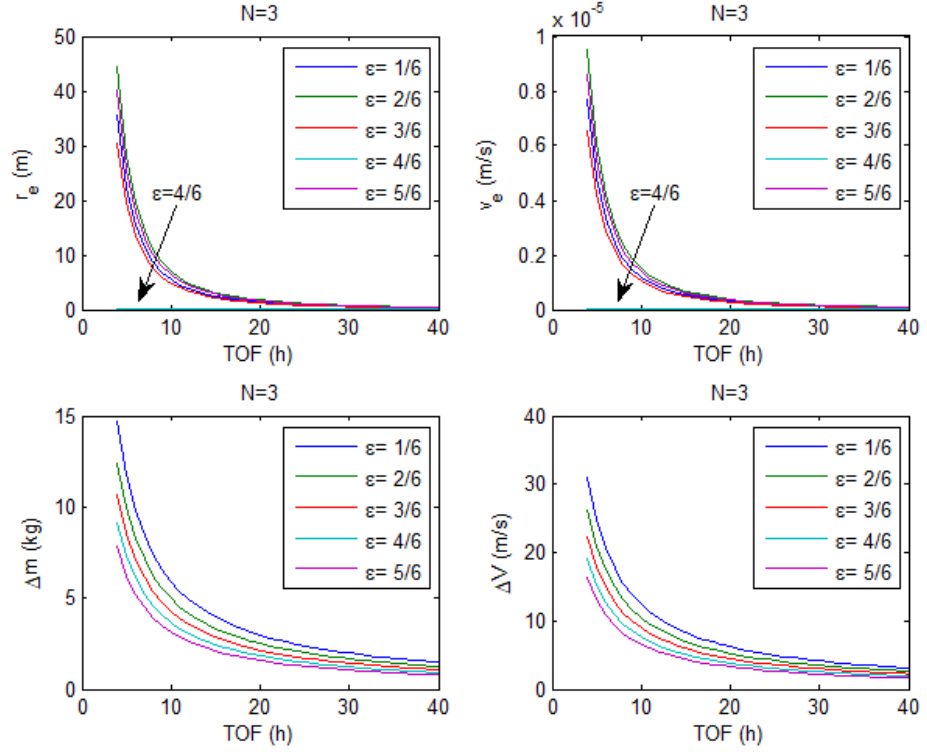
Figure 1. Control performance (baseline trajectory, N = 3).